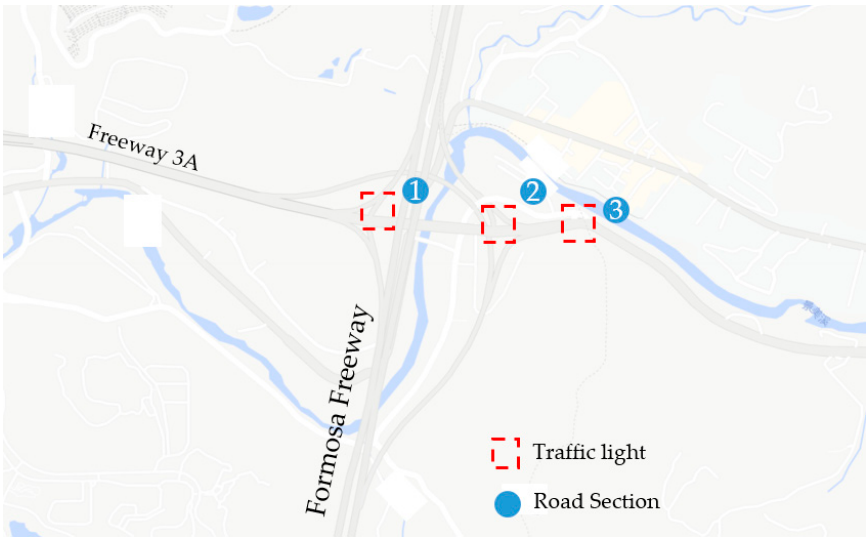
Figure 1. The Google Map of the three intersection roads (red blocks) in an interchange of Shenkeng of the Formosa Freeway in Taiwan.